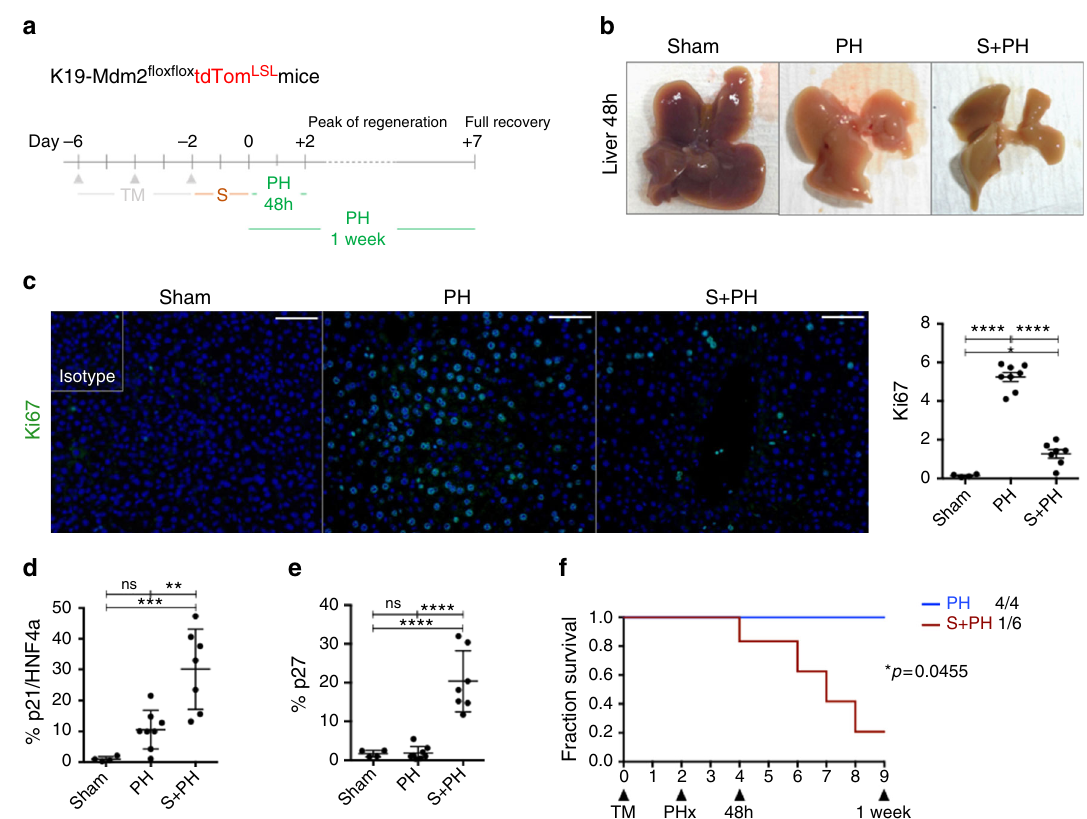
Fig. 5 Cellular senescence in cholangiocytes impairs the regenerative response of liver parenchyma. a Schematic representation of the experiment. After induction of the model, we waited 2 days for display of senescence and performed 70% PH. Livers were recovered at day 2 after the surgery (peak of DNA replication in hepatocytes) and day 7 (when the liver mass is restored). Two groups were included in this experiment; PH ( N = 8) and Senescence + PH (S + PH, N = 7). Sham animals are included as controls of the PH technique ( N = 4). b Whole livers collected at 48 h post PH. From left to right: Sham (no manipulation of the liver), PH (which shows normal regenerative process by compensatory hypertrophy) and S + PH. Notice the absence of compensatory hypertrophy in the S + PH liver. c Decrease of Ki67 (green) in the S + PH group in comparison with PH group and Sham at 48 h post PH. Far right, quanti fi cation of total proliferation in the liver. * p < 0.05, **** p < 0.0001, (Mean ± SEM). ANOVA, Sidak ’ s multiple comparisons test. Scale bars = 50 µ m. d Increase of p21-positive hepatocytes in S + PH group at 48 h post-PH. ** p < 0.01, *** p < 0.001 (Mean ± SEM). ANOVA, Sidak ’ s multiple comparisons test. e Increase of total p27 in S + PH group at 48 h post-PH. **** p < 0.0001 (Mean ± SEM). ANOVA, Sidak ’ s multiple comparisons test. f Survival curve for PH vs. S + PH at 1 week show a signi fi cant decrease of survival for S + PH mice (PH, N = 4; S + PH, N = 6). Log-Rank (Mantel − Cox